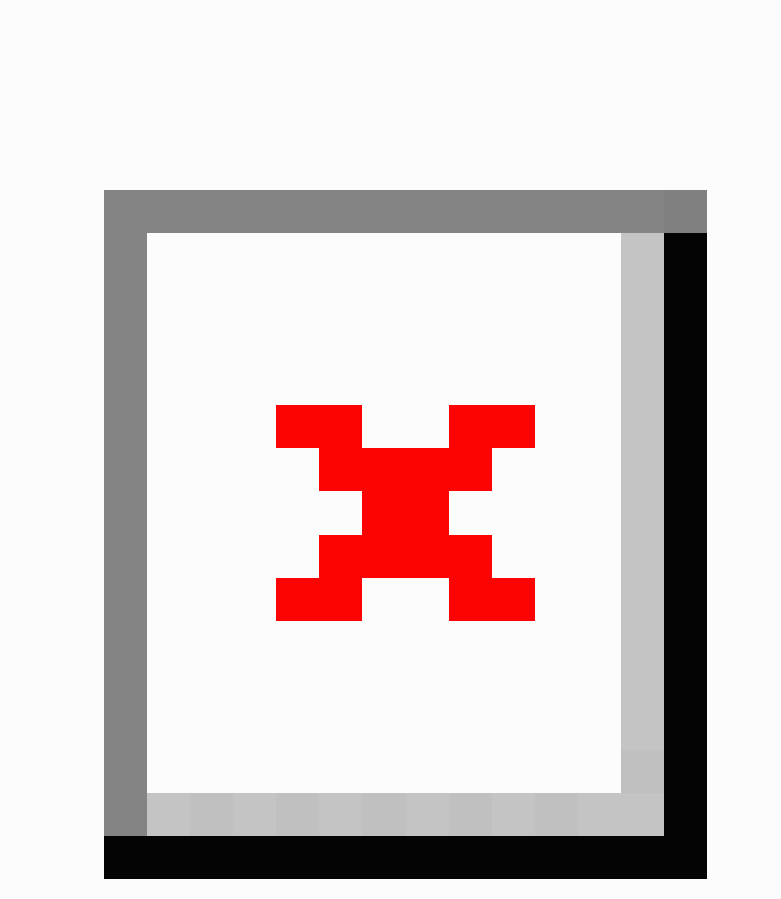
Figure 2. Classification criteria of functionalities. The criteria originated from the classification of digital health interventions proposed by the WHO and were tailored to this study. As opposed to the WHO criteria, prescription and medication management, identification and registration, and telemedicine were not under a single category of HCP or non-HCP because they could be mutual processes. Targeted client communication, untargeted client communication, client-to-client communication, and HCP communication were summarized as "communication." “Records” included personal health tracking and health records. Referral coordination was removed from our study because no app provided this service. HCP: health care professional; WHO: World Health